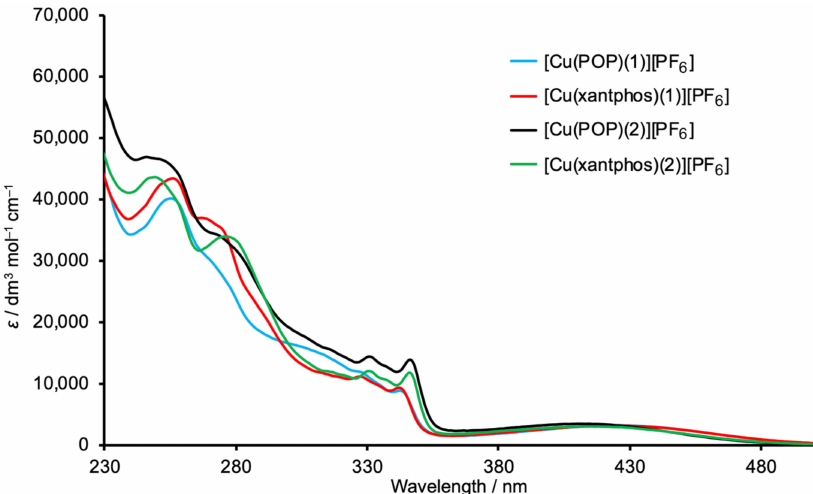
Figure 9. Solution absorption spectra of the copper(I) compounds in CH 2 Cl 2 (2.5 × 10 –5 mol dm –3 for complexes with ligand 1 and 2.1 × 10 –5 mol dm –3 for those containing 2